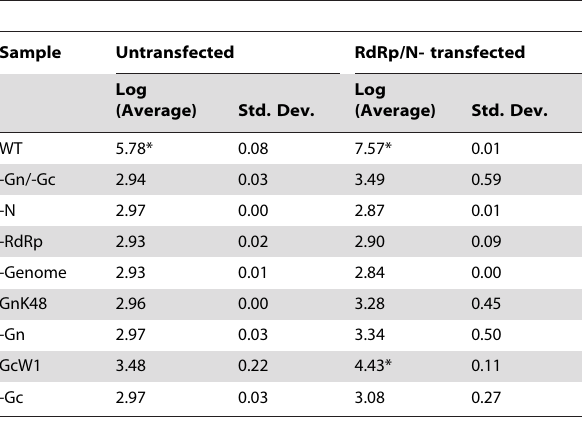
Table 5. Benzonase treatment reduces background RLuc activity.